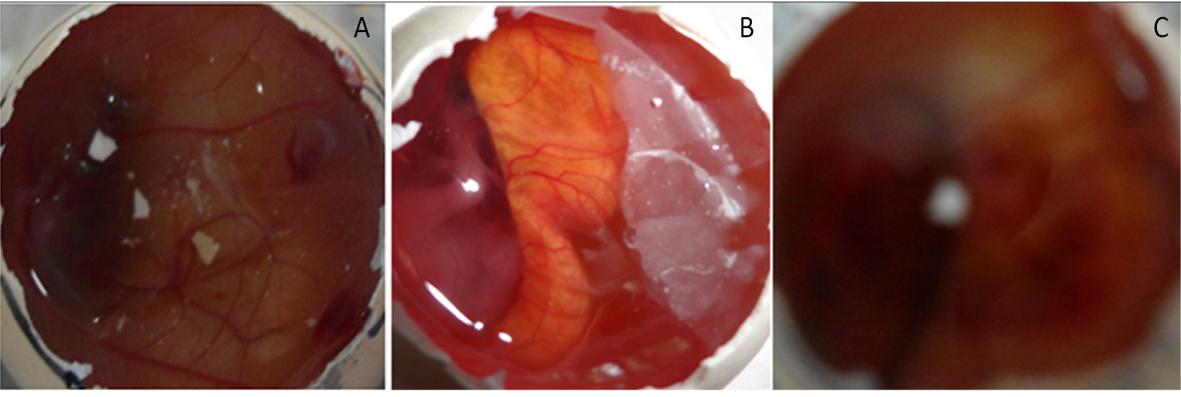
Figure 8. HET-CAM image of ( A ). EM-NLCs-opt-IG4, ( B ). Negative control (0.9% NaCl) and ( C ). Positive control (0.1 N NaOH).